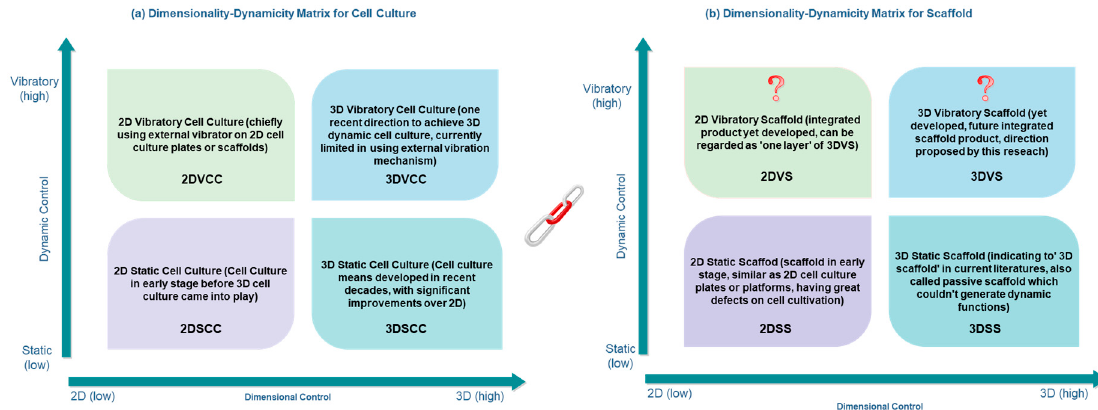
Figure 2. A graphic illustration regarding ( a ) four main stages in cell culture development, and ( b ) development aspects in terms of scaffold engineering for cell culture applications.